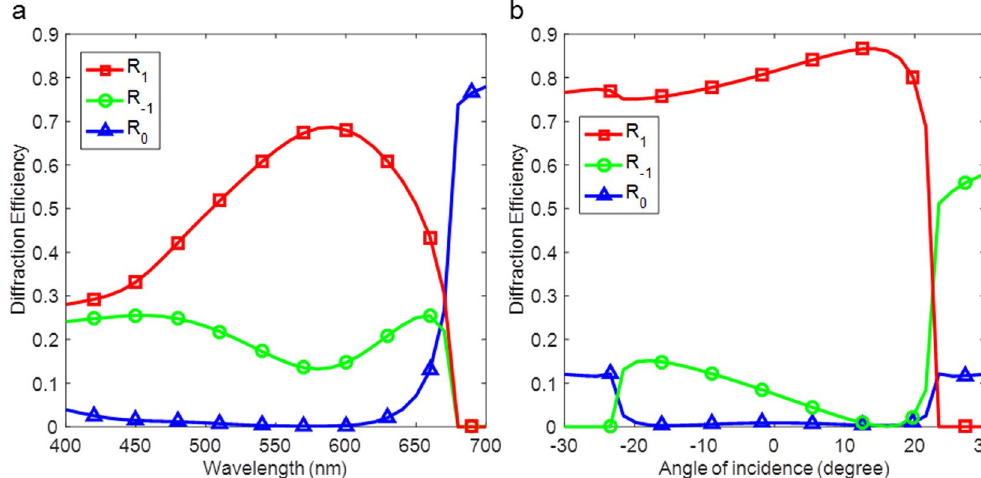
Figure 5. Broadband operation and optimal design for red wavelength. ( a ) Simulated spectra of diffraction efficiency of TM waves for the reflection mode metasurface at normal incidence, in the 400 to 700 nm wavelength range. The nanostructures of this metasurface were described in Fig. 2. ( b ) Simulated diffraction efficiency of TM waves versus incidence angle for different reflection mode metasurface at wavelength of 638 nm. This metasurface is optimized to efficiently diffract light over a wide range of incidence angles at wavelength of 638 nm. The nanobeams optimized for red wavelength have a thickness of 35 nm and widths of 30 nm and 90 nm, with an edge-to-edge gap of 60 nm. The red solid line with square markers shows the diffraction efficiency of the + 1 reflected order, the green line with circle markers represents the diffraction efficiency of the − 1 reflected order and the blue line with triangular markers shows the zeroth order